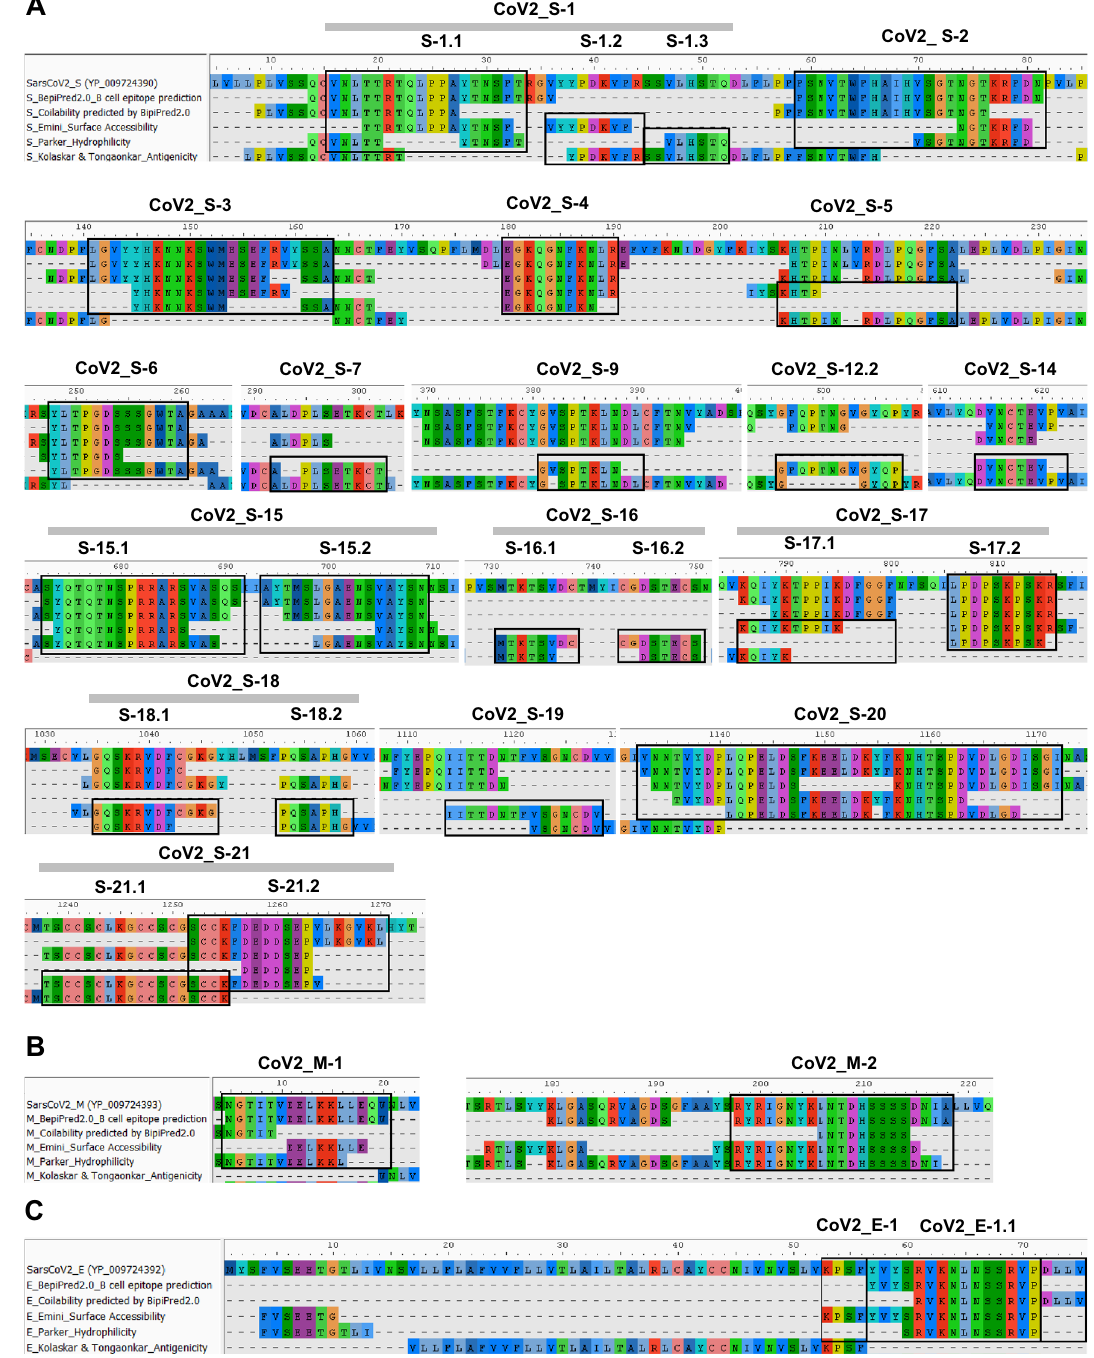
Figure 5. Prediction of linear B cell epitope in the S, M and E proteins using immunoinformatics approach. Amino acid sequences of the SARS-CoV-2 S ( A ), M ( B ) and E ( C ) proteins were predicted with the tools indicated and then aligned. Linear B cell epitopes were identified based on the bioinformatics methods A, B and C. Selected sequences are indicated (in boxes) with designated epitope